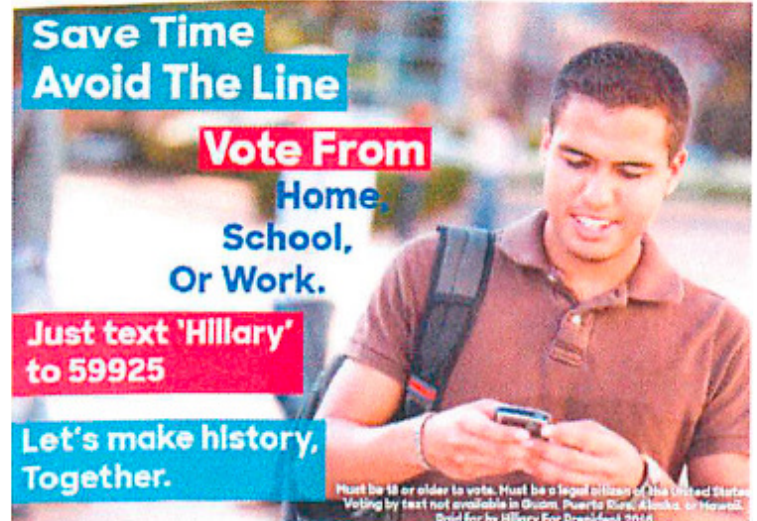
Figure 2. Russian created meme, 2016. Source: U.S. House of Representatives Permanent Select Committee